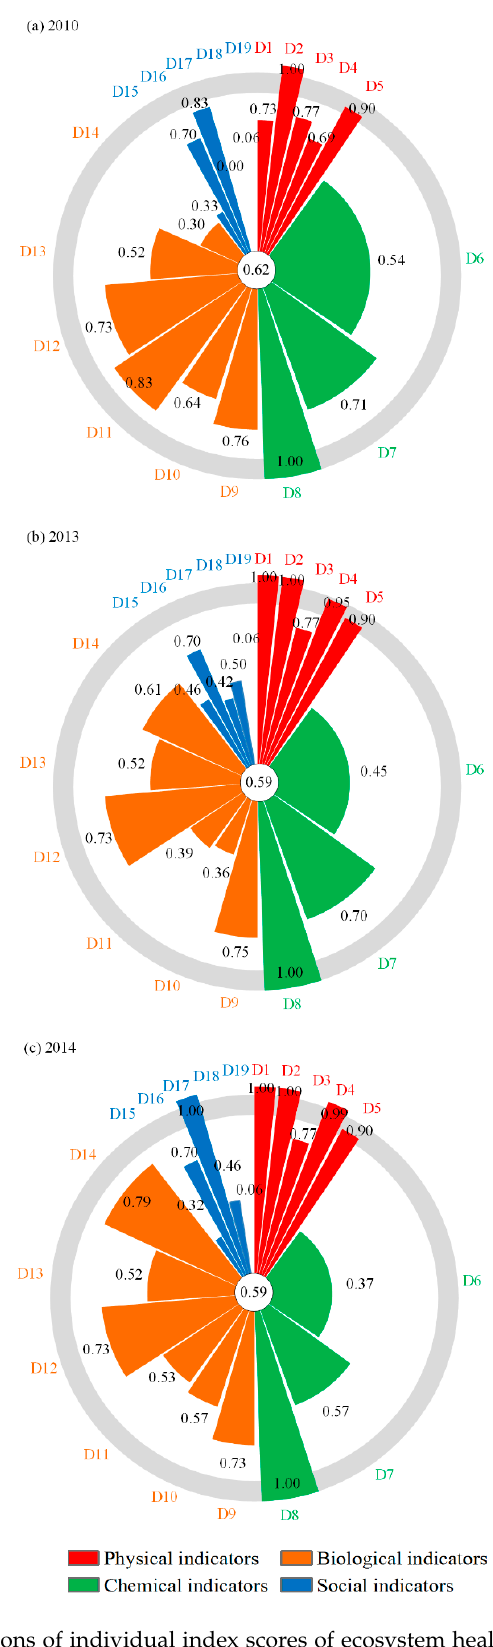
Figure 3. Annual variations of individual index scores of ecosystem health assessment in 2010 ( a ), 2013 ( b ) and 2014 ( c ).